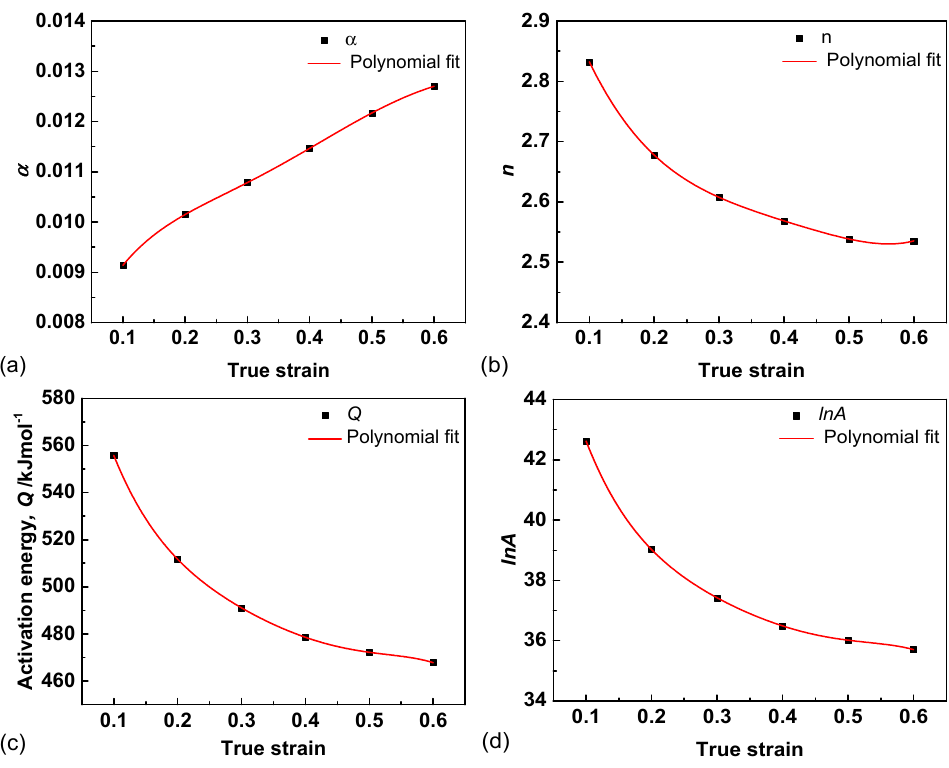
Figure 2. Polynomial relations of ( a ) α ; ( b ) n ; ( c ) Q and ( d ) ln A to true strains .